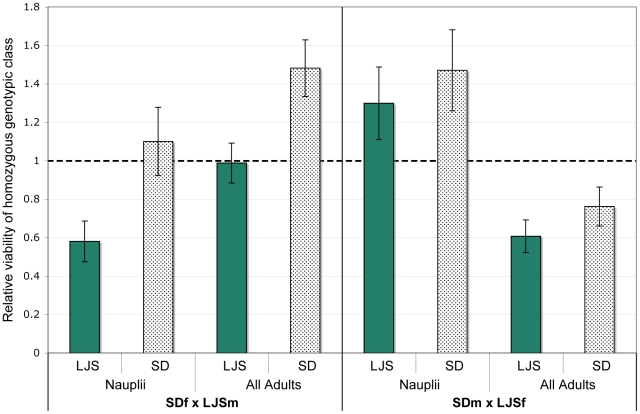
Relative viability at ME2 for SD x LJS population crosses of T. californicus.The relative viability of the two homozygous genotypic classes in comparison to the heterozygous genotypic class is given for ME2 in both adult and nauplii F2 hybrids from crosses of the SD and LJS populations. Relative viabilities and standard deviations are depicted as described for Figure 2. SD indicates the SD/SD homozygous genotypic class while LJS indicates the LJS/LJS genotypic class. Full numerical results are available in Table S2.